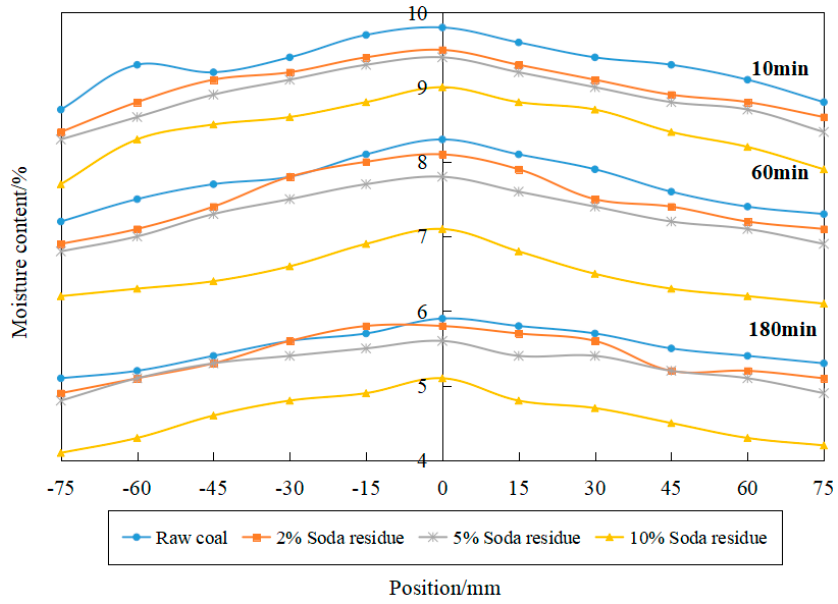
Figure 9. Effects of additives on humidity transfer from edge to center in coal.